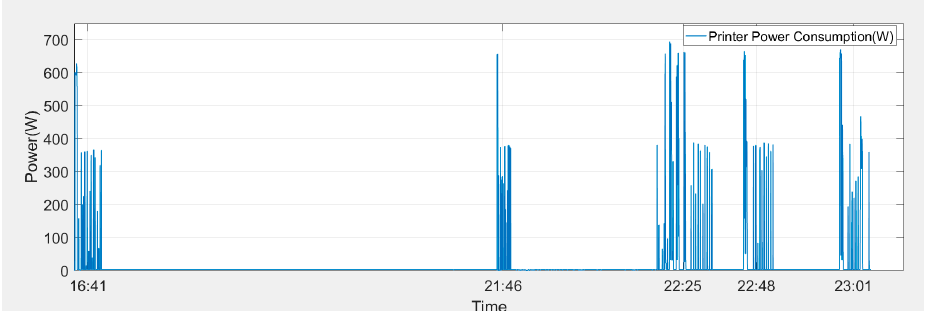
Figure 19. The example power consumption curve for the laser printer.